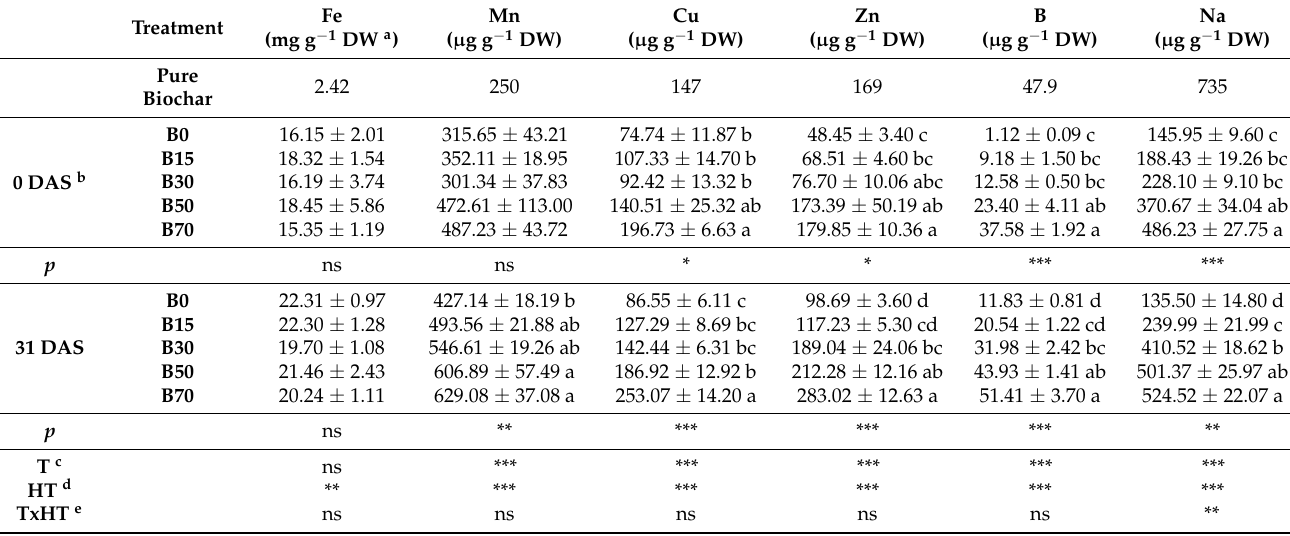
Table 4. Total contents of micro-nutrients (Fe, Mn, Cu, Zn and B) and sodium (Na) detected in different peat:biochar substrates (Treatment: T) at the beginning (0 DAS) and the end of the experiment (31 DAS). Harvest Time (HT) is the time when substrate samples were collected at 0 and 31